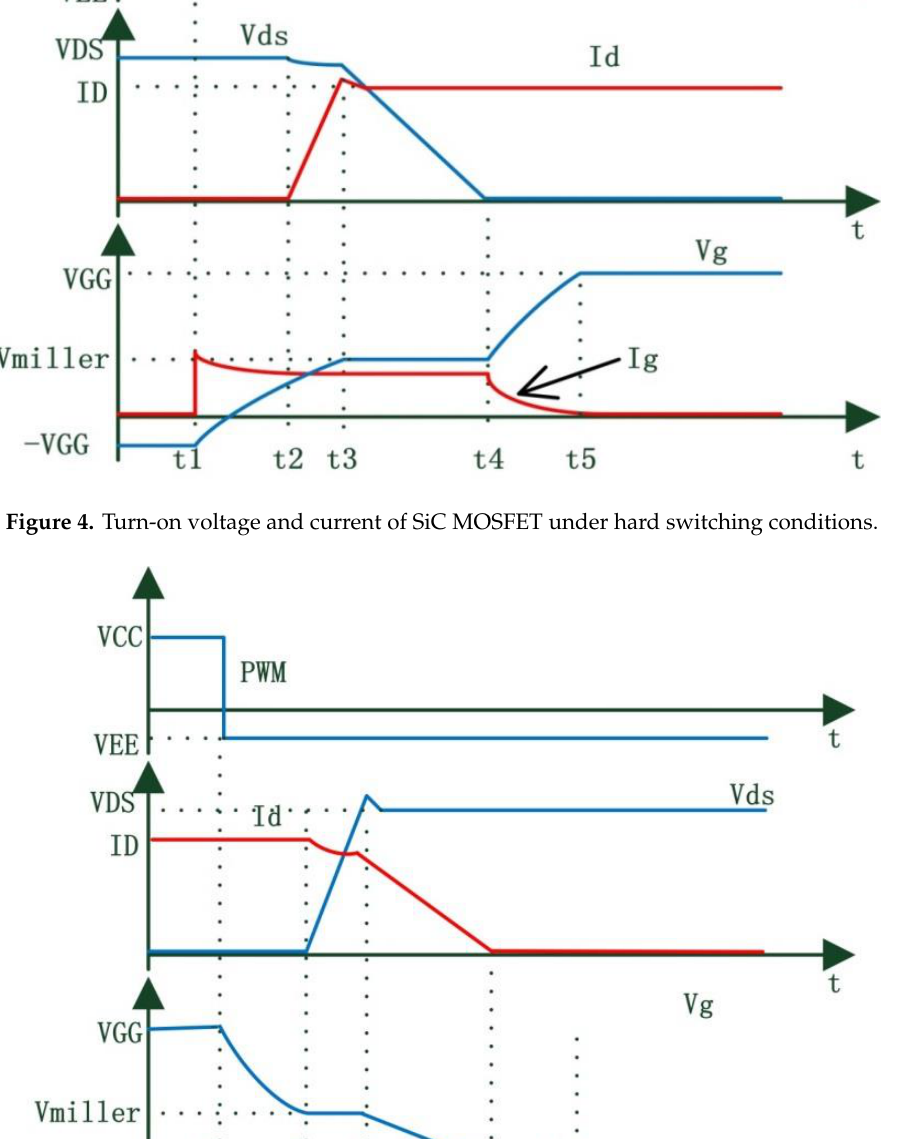
Figure 5. Turn-o ff voltage and current of SiC MOSFET under hard switching Figure 5. Turn-off voltage and current of SiC MOSFET under hard switching conditions. Time domain diagram of Gaussian control signals for voltage and current is shown in Figure 6. S1(t) and S2(t) are rising edges for drain voltage and current respectively and the falling edge signal is symmetric with the rising edge signal. They can be obtained by Equation (11).